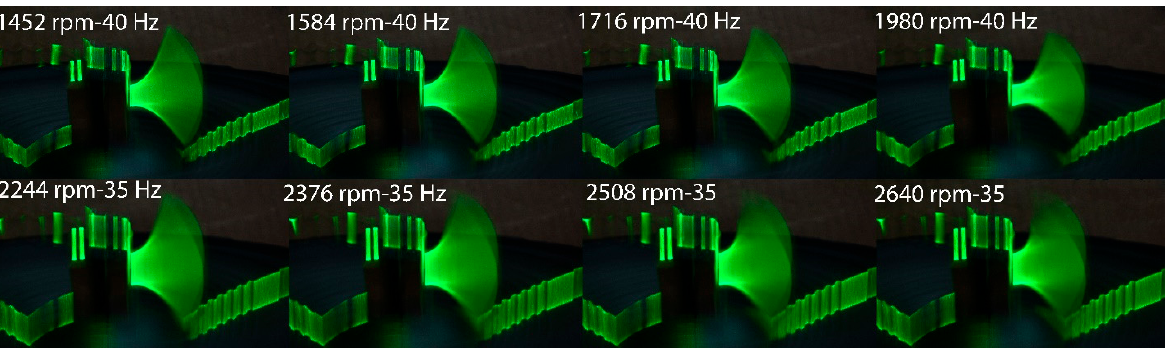
Figure 13. Laser projection of the piezo film with only base excitation in various frequencies.